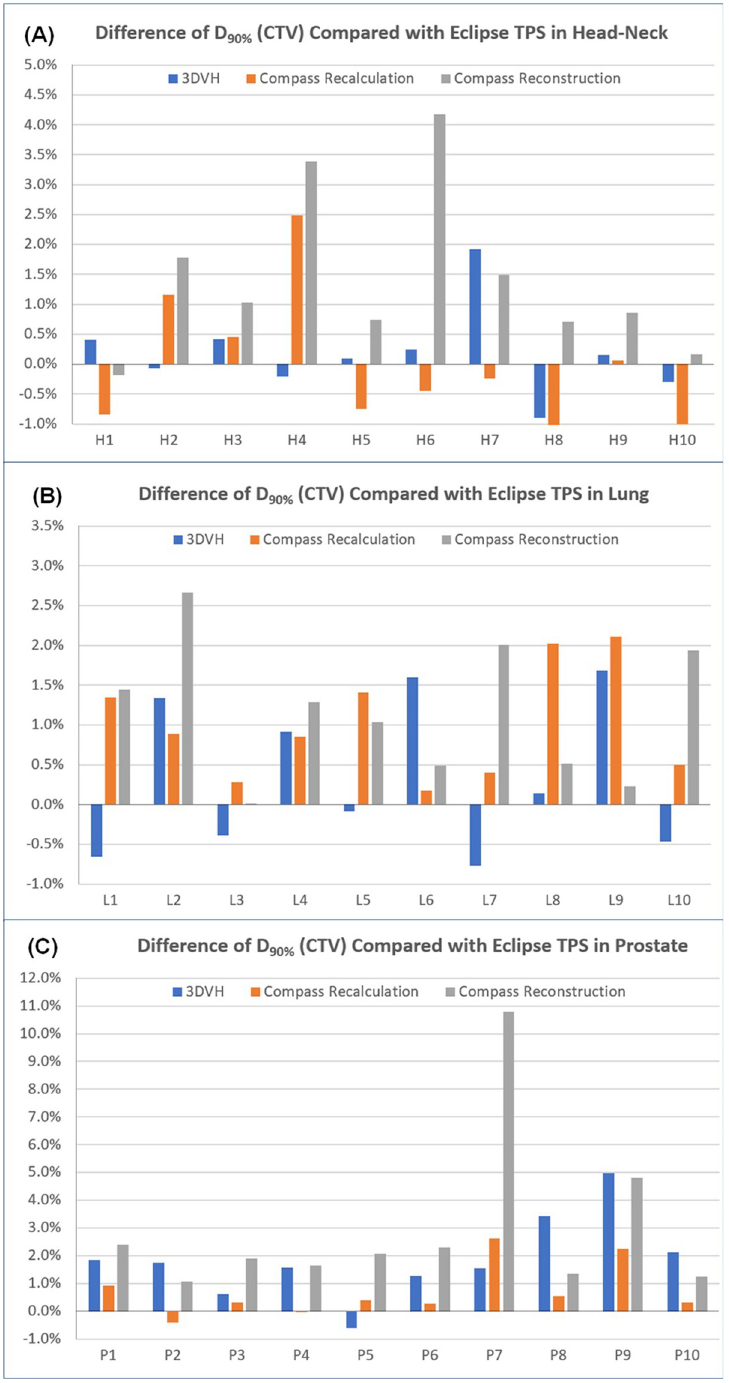
Fig 8. Difference of D 90% (CTV) calculated using 3DVH and compass compared with a reference value calculated in Eclipse TPS. (A) head-neck plans, (B) lung plans, (C) prostate plans.